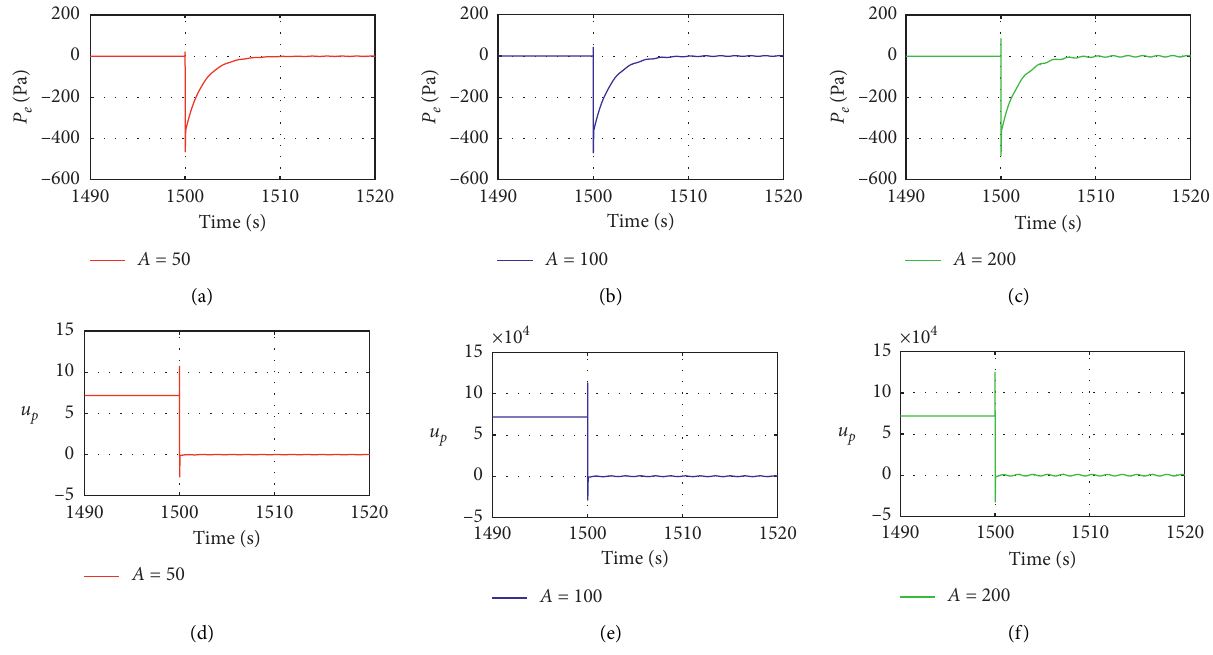
Figure 18: Pressure error and control input of three situations after